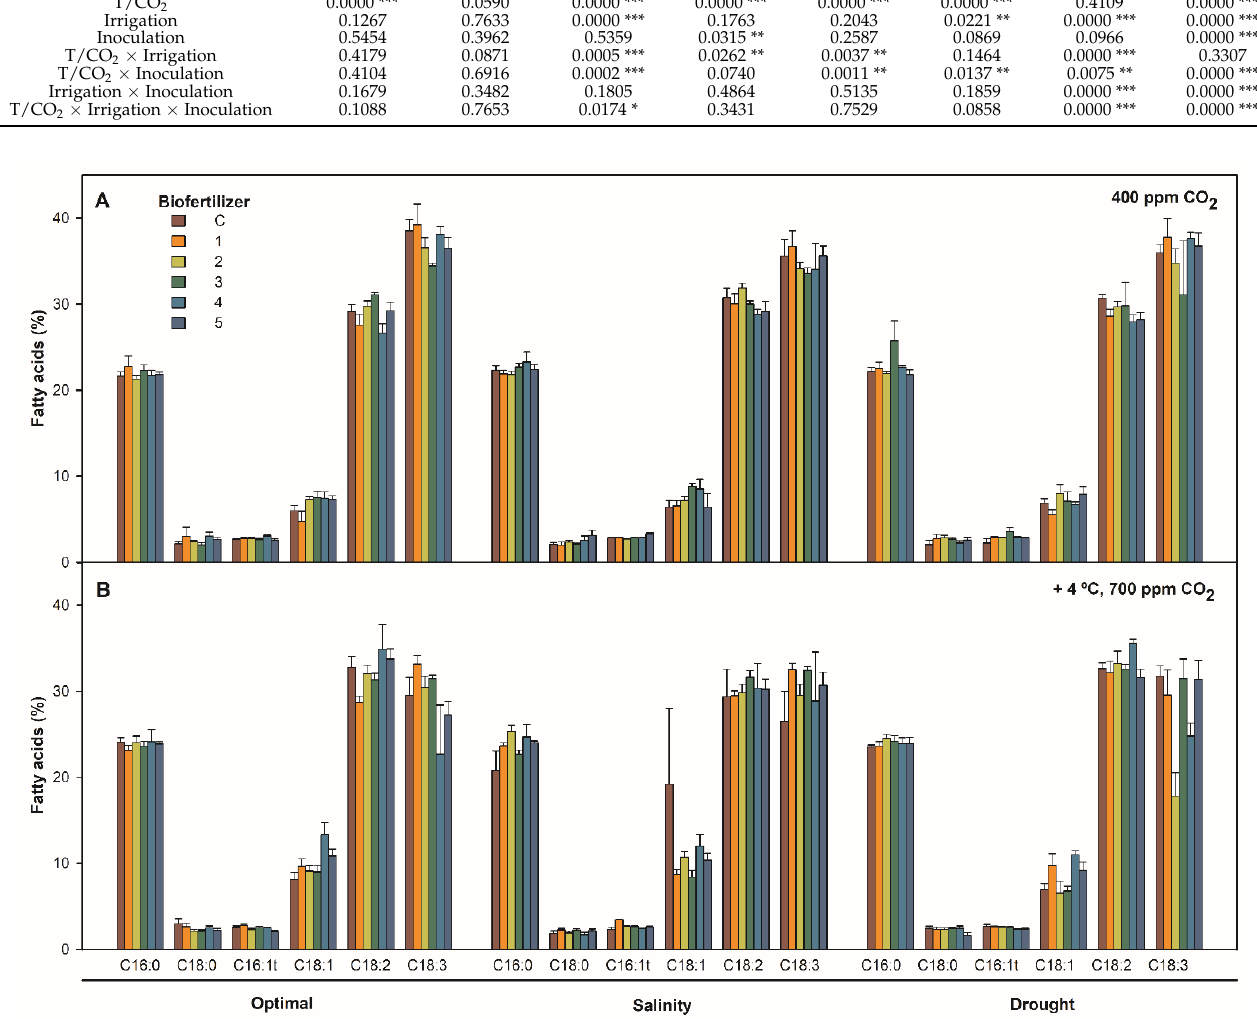
Figure 1. Relative content of FA in S. ramosissima shoots, as expressed by percentage, after 30 days under irrigation (optimal 171 mmol L − 1 NaCl, salinity 510 mmol L − 1 NaCl, and drought) and inoculation (control non-inoculated—C, and biofertilizers 1 to 5) treatments in ( A ) 25/14 ◦ C 400 ppm CO 2 chamber and ( B ) 29/18 ◦ C 700 ppm CO 2 chamber. Values are means ± S.E. ( n = 5) (GLM: T/CO 2 × Irrigation × Inoculation, p > 0.05). Table 1. Fatty acids for S. ramosissima shoots after 30 days of the experiment: saturated FA (SFA), monounsaturated FA (MUFAs), polyunsaturated FA (PUFA), and indexes of lipid nutritional qual- ity: oxidizability (Cox), oxidative susceptibility (OS), hypocholesterolemic/hypercholesterolemic (h/H), peroxidizability (PI), atherogenic index (AI), thrombogenic index (TI), and omega 3 and omega 6. Values are means ± S.E. (n = 5).